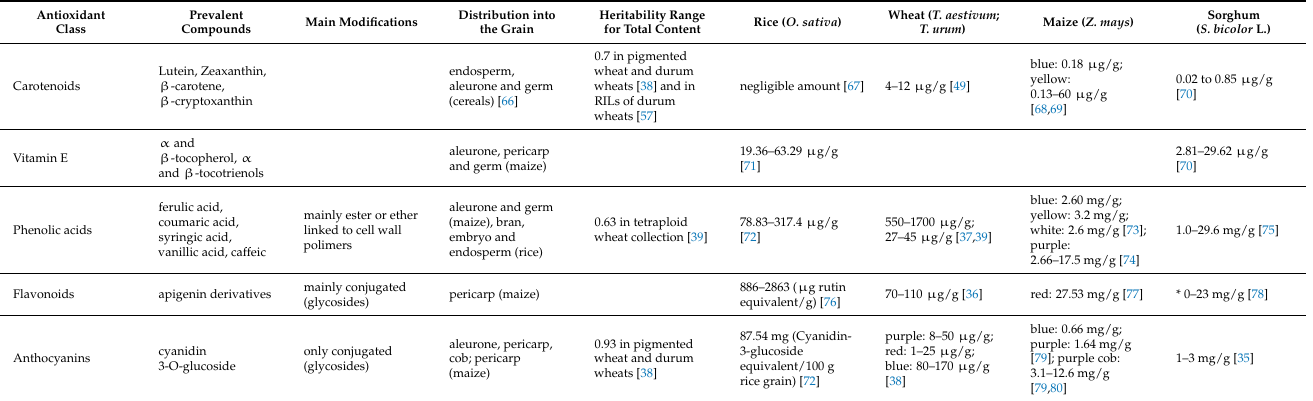
Table 1. Typical range of concentrations of phytochemicals in cereal crops. * no antioxidant effect since they are